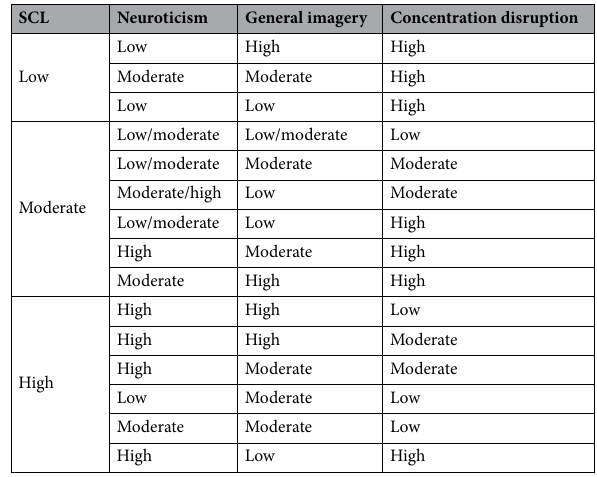
Table 2. Impact matrix of SCL level for possible configuration of the predictors from Model 2.